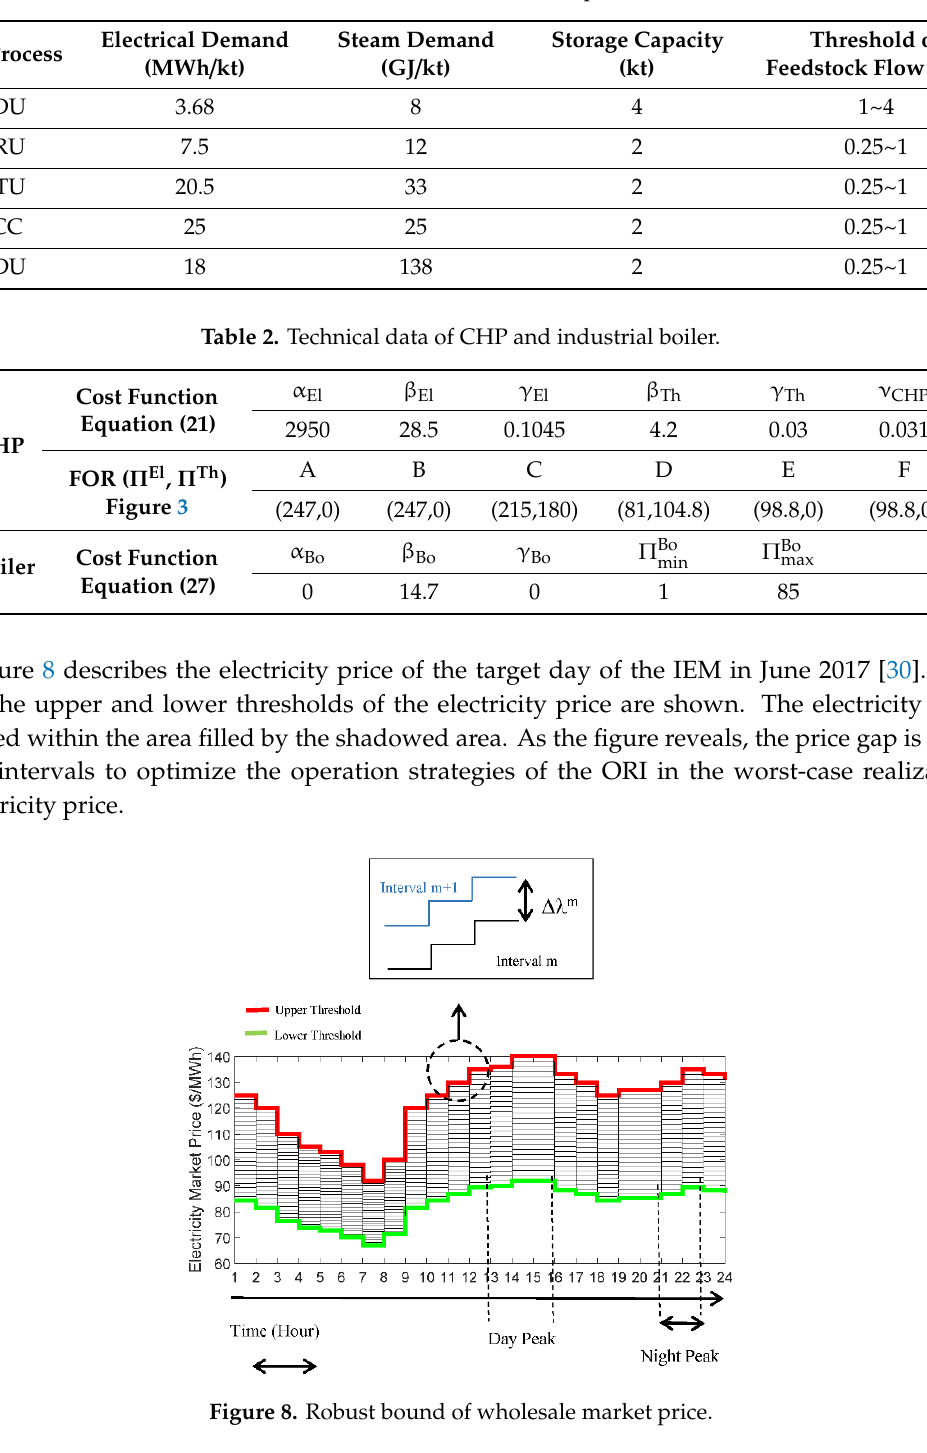
Table 1. Technical characteristics of the pilot Pars ORI.